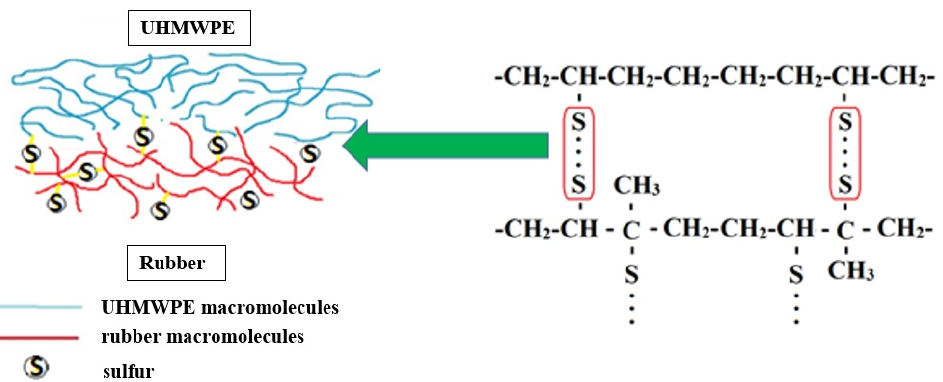
Figure 8. Dependence of bond strength between elastomer and UHMWPE on the content of DPG, MBT, and TMTD.